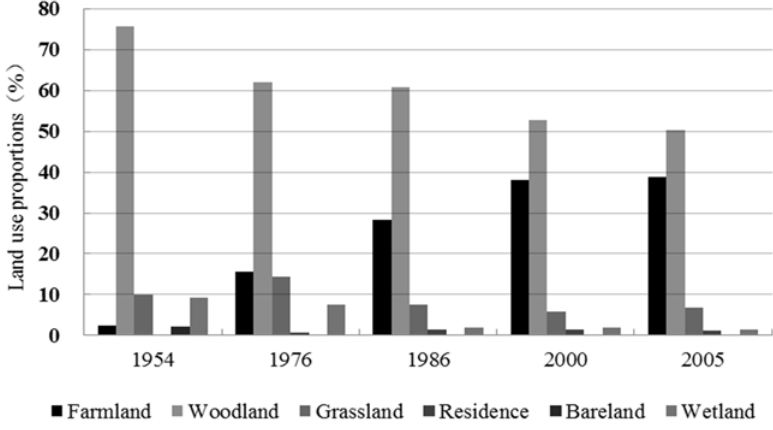
Figure 4. Changes in the proportional extent for five land use classes in the upper Naoli River watershed.